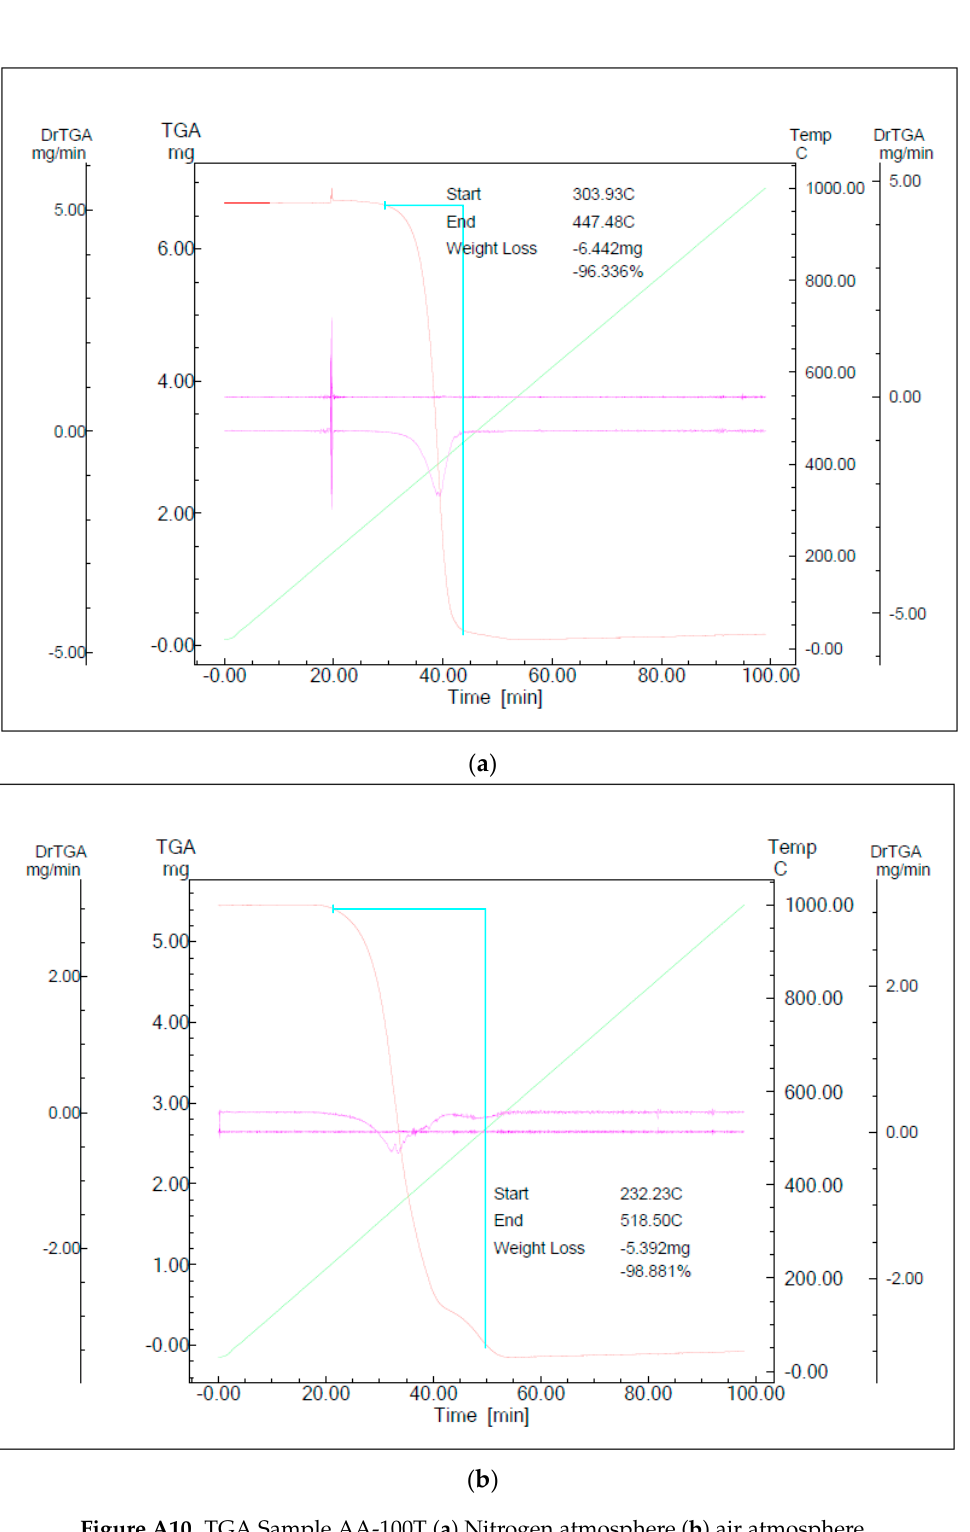
Figure A10. TGA Sample AA-100T ( a ) Nitrogen atmosphere ( b ) air